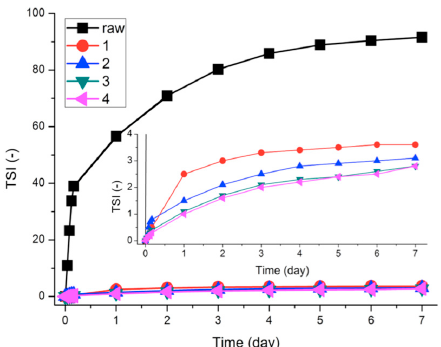
Figure 5. Time-evolution turbiscan stability index (TSI) curves for pristine HOPG ( raw ) and pristine HOPG with PTFEMA 66 - b -PVP 41 ( 1 ), PTFEMA 66 - b -PVP 205 ( 2 ), PTFEMA 136 - b -PVP 31 ( 3 ), and PTFEMA 136 - b -PVP 194 ( 4 ). The TSI values are calculated for the middle parts of the sample vials shown in Figure 6. The inset shows magnified TSI curves for samples 1 – 4 .